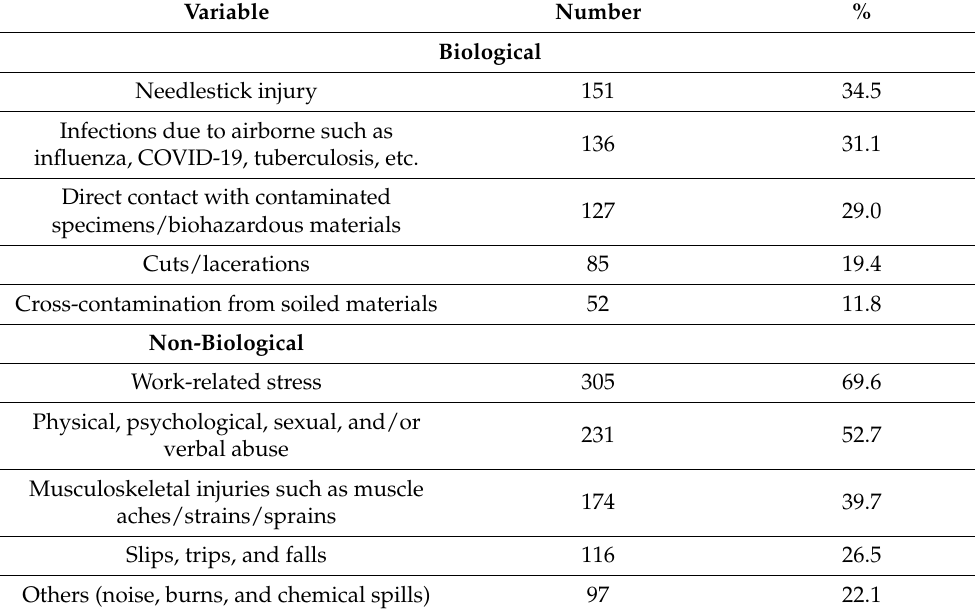
Table 2. Pattern of occupational health hazards faced by the study participants ( n =